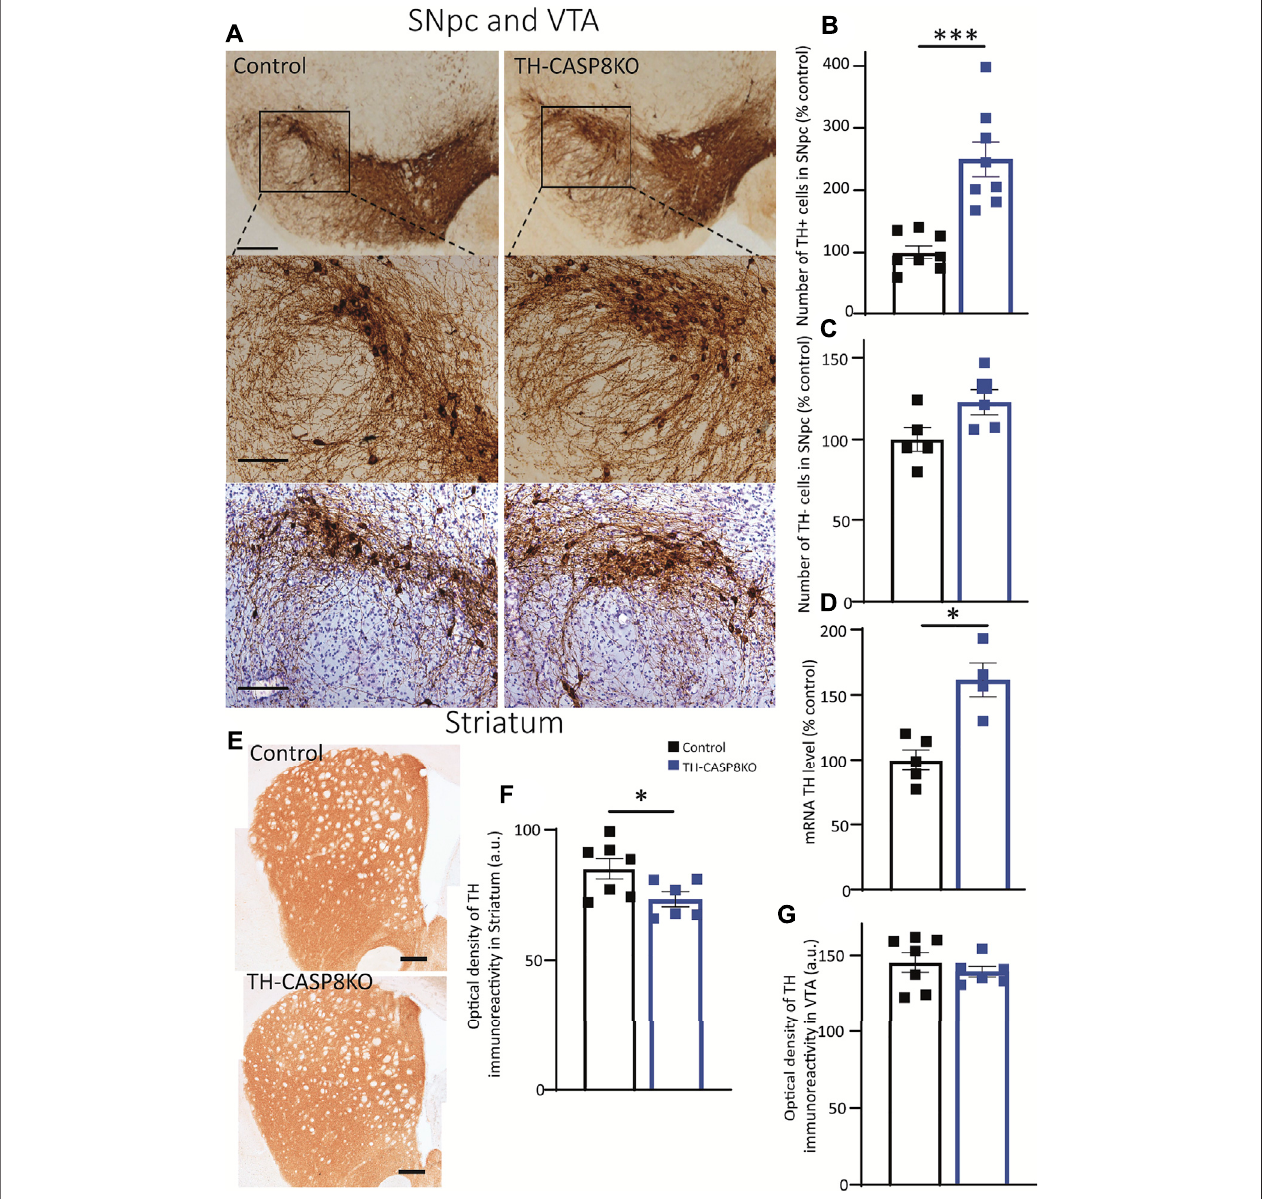
FIGURE2| Effectof CASP8 deletion onTHexpression. (A) CoronalsectionsofSNfromcontrolandTH-CASP8KO animalsshowingimmunoreactivityagainstTH. A more intense staining can be observed in the TH-CASP8KO animal. Lower panels show the immunohistoquemistry costained with Nissl. The deletion of CASP8 generated differences in the percentage of TH + cells (n = 8 mice/group) (B) and in the expression level of TH mRNA (n = 4 mice/group) (D) in SNpc. (C) Quanti fi cation of TH-negative-Nissl-positive cells in the SN of control and TH-CASP8KO animals. (G) Optical density of the immunoreactivity in VTA, expressed in a. u. (E) Coronal sections of striatum of control and TH-CASP8KO animals showing immunoreactivity against TH. The deletion of CASP8 decreased the optical density of TH immunoreactivity in the striatum. Scale bar 100 and 200 µm. (F) . Data are expressed as mean ± SEM of n = 7-6 mice/group. The two-tailed unpaired t test was used. *, p < 0.05; ***, p < 0.05 versus control